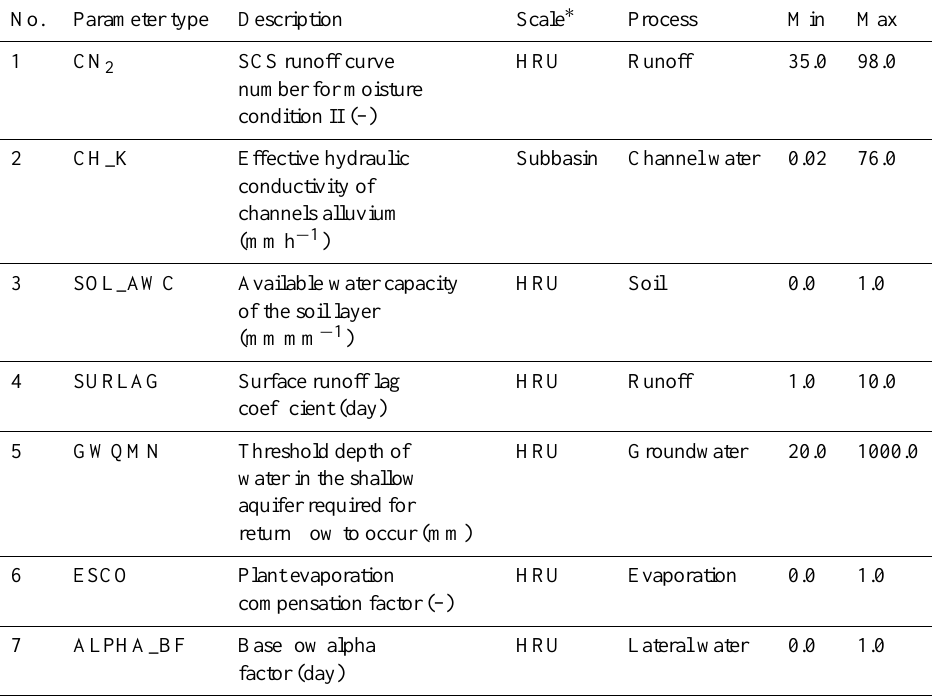
Table 1. Model parameters to be estimated in data